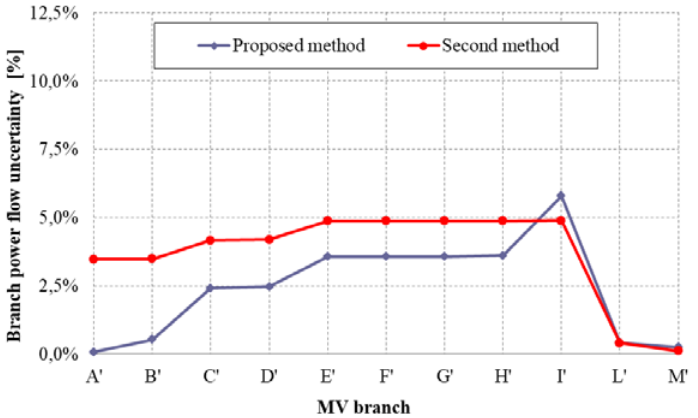
Figure 7. Branch power flow uncertainty with seven PMs located in the Vittorio Emanuele feeder: comparison with a second placement method.